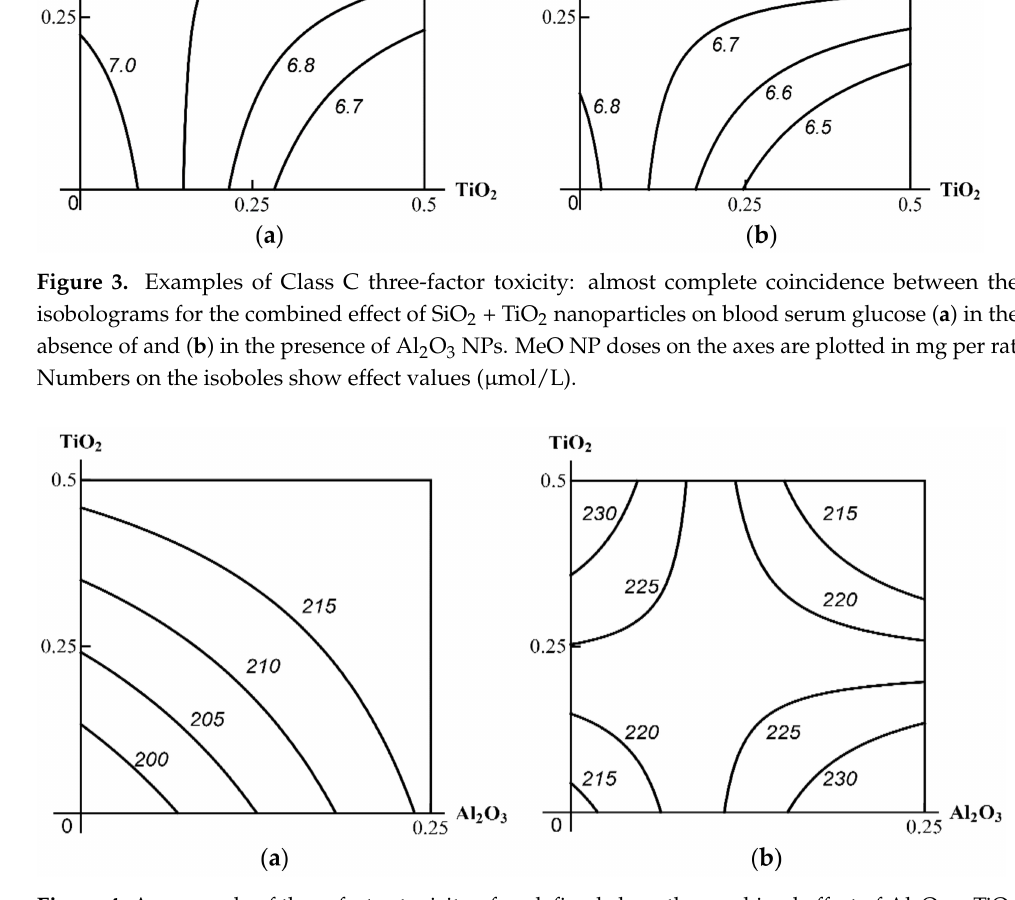
Figure 4. An example of three-factor toxicity of undefined class: the combined effect of Al 2 O 3 + TiO 2 nanoparticles on alkaline phosphatase activity in blood serum ( a ) in the absence of a third factor, and ( b ) in the presence of SiO 2 (see the text for interpretation). MeO NP doses on the axes are plotted in mg per rat. Numbers on the isoboles show effect values